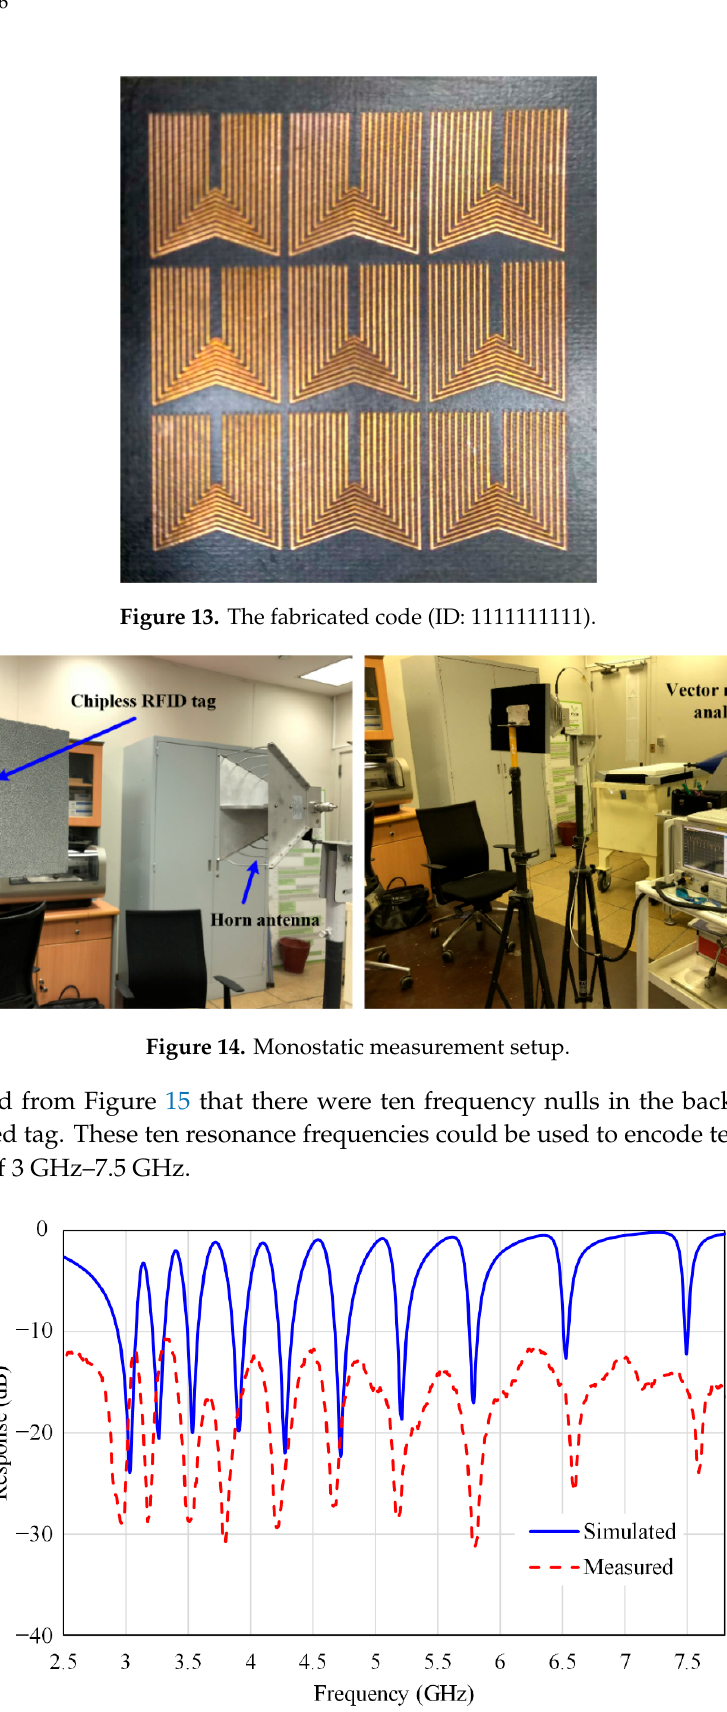
Figure 15. Simulated and measured values of S 11 for the all-ones code at a 10 cm distance from the RFID reader.